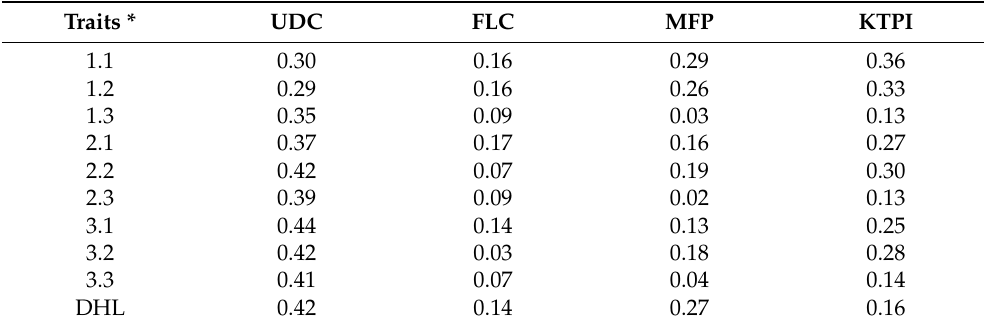
Table 7. Breeding value correlations among the composite index and sires’ direct herd life for Korean Holstein. Traits * UDC FLC